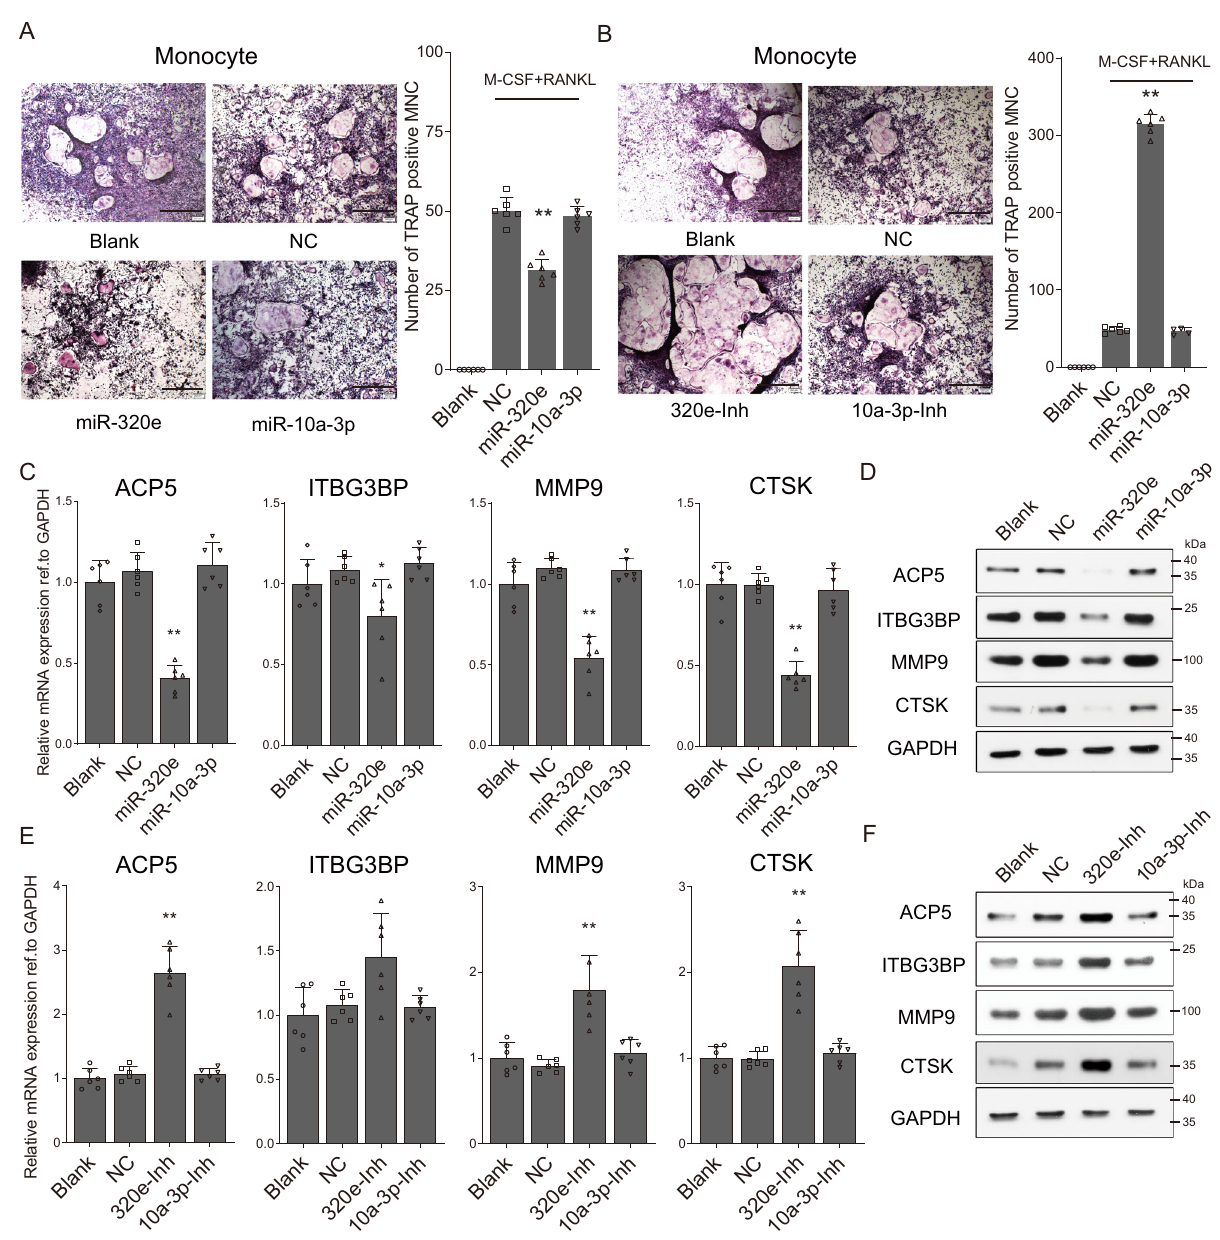
Fig. 5 miR-320e inhibits the osteoclastogenesis of monocytes. Osteoclast differentiation was induced by treating the human monocyte cells with 30 ng/ml M-CSF and 100ng/ml RANKL. Cells were fi xed and stained for Tartrate-resistant acid phosphatase (TRAP) activities at days 20 in miR-320e and miR-10a-3p overexpression ( A ) and inhibition groups ( B ), n = 6, the scale bars represent 500 μ m. The quanti fi cation of osteoclast precursors is shown in the right panel, respectively (compared to NC group using two tailed t test). The quanti fi cation of expression of osteoclastogenesis related genes were detected using either qRT-PCR ( C , n = 6, compared to NC group using two tailed t test) or Western blot ( D , n = 3 biologically independent repeats with similar results) in in miR- 320e and miR-10a-3p overexpressed monocytes. Similarly, the quanti fi cation of expression of osteoclastogenesis related genes were detected using either qRT-PCR ( E , n = 6, compared to NC group using two tailed t test) or Western blot ( F , n = 3 biologically independent repeats with similar results) in in miR- 320e and miR-10a-3p inhibited monocytes. GAPDH level were detected and served as internal reference. All data were presented as the mean±SD. * p < 0.05, ** p <0.01. Detailed statistical data and source data are provided in a Source Data fi